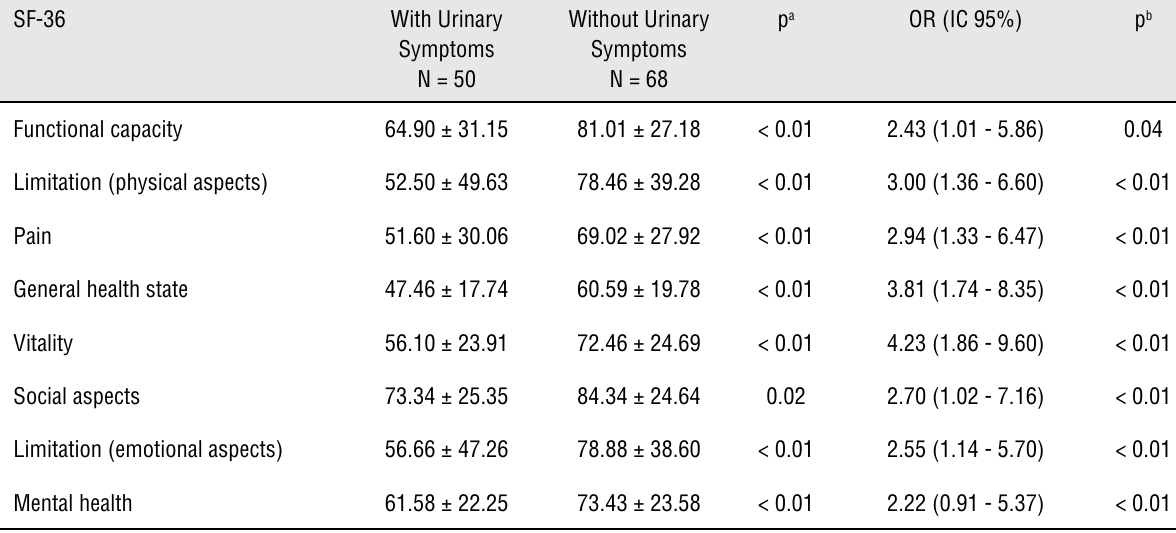
p a OR (IC 95%) p b Without Urinary Symptoms Symptoms N = 68 N = 50